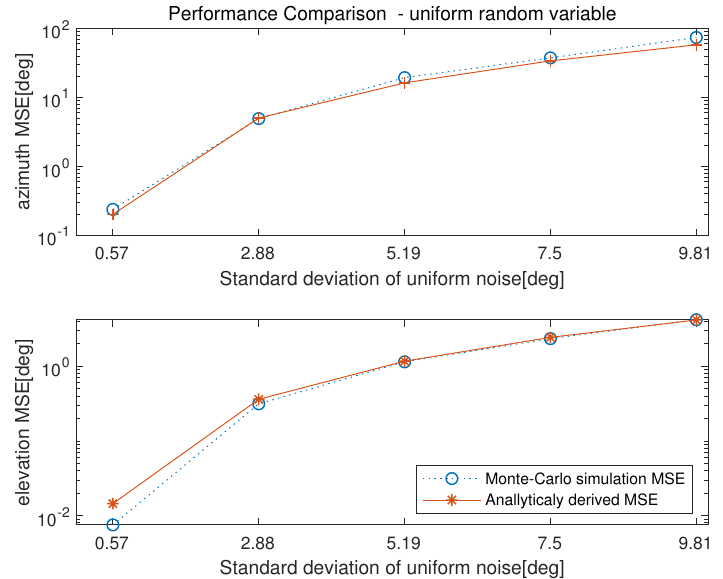
Figure 7. Performance for uniformly − distributed phase measurement error with θ ( 0 ) = 120 ◦ and ψ ( 0 ) = 75 ◦ . This figure shows the MSEs of azimuth and elevation with respect to phase error at a signal with high incident elevation. It can be confirmed that the MSE of elevation is smaller than that of the azimuth at high elevation(uniform circular